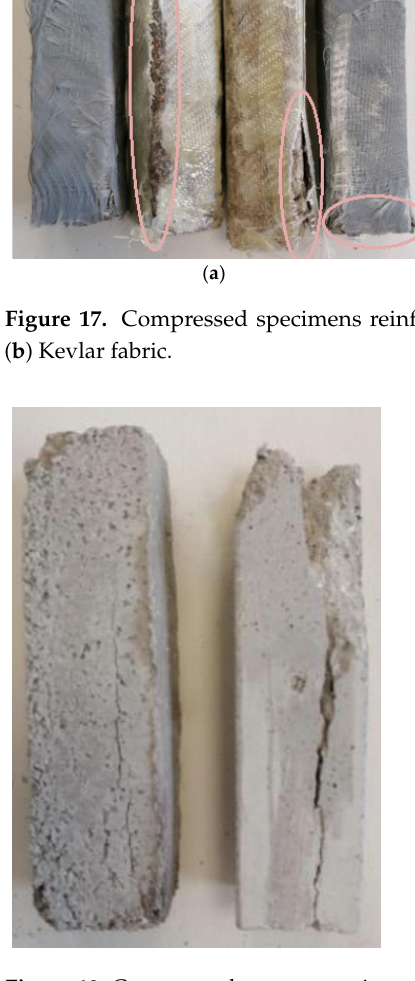
Figure 18. Compressed cement specimen without reinforcement